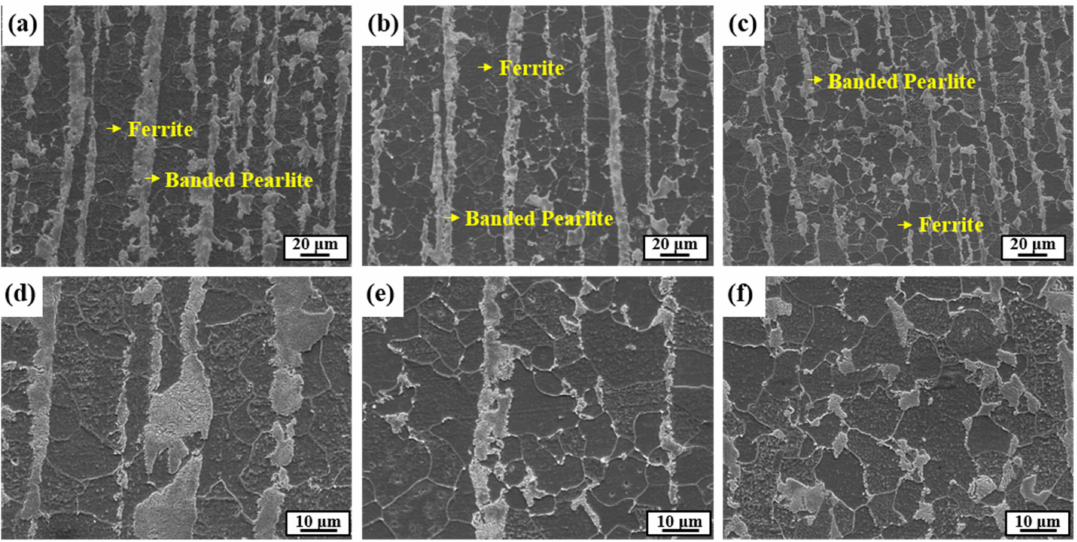
Figure 1. Microstructures observed by FE-SEM: ( a , d ) Steel A, ( b , e ) Steel B, and ( c , f ) Steel.